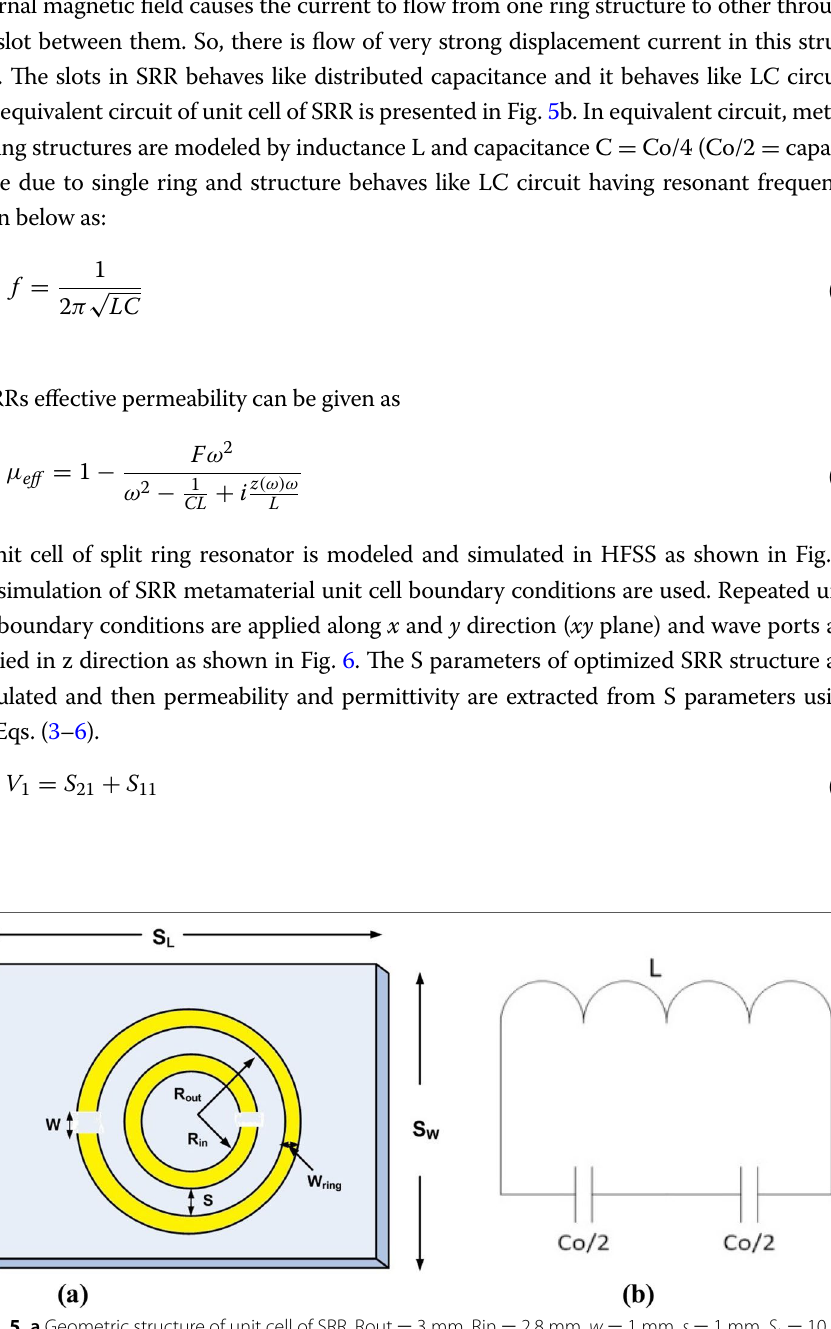
3 mm, Rin 2.8 mm, w 1 mm, s 1 mm, S L 10 = = = = =